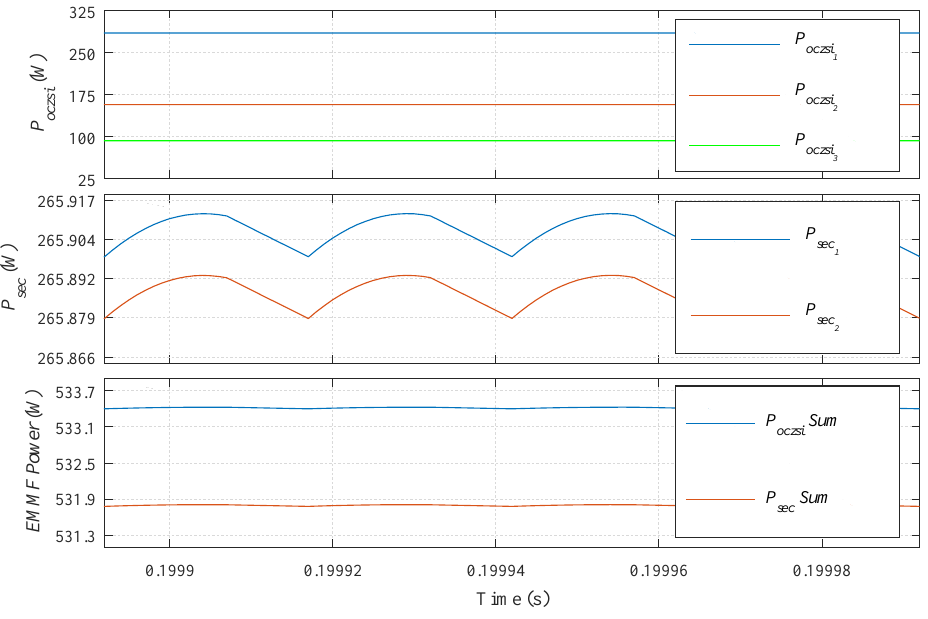
Figure 10. Simulation results: CZSI modules output current i oczsi currents i sec and i sec under unbalanced conditions. 2 1